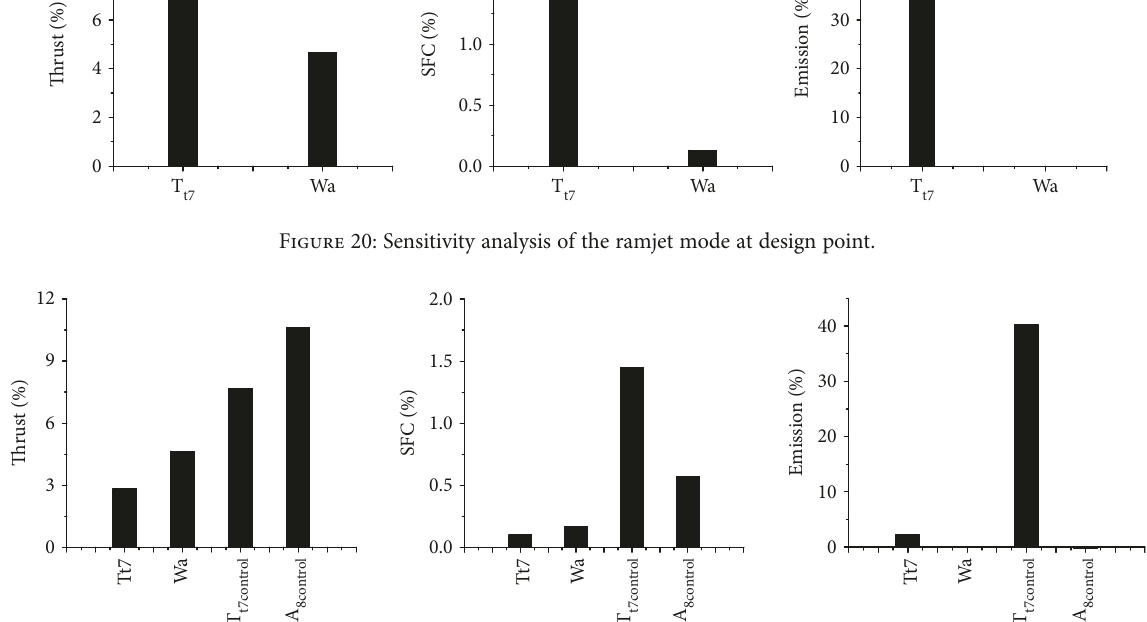
Figure 21: Sensitivity analysis of the ramjet mode at cruising